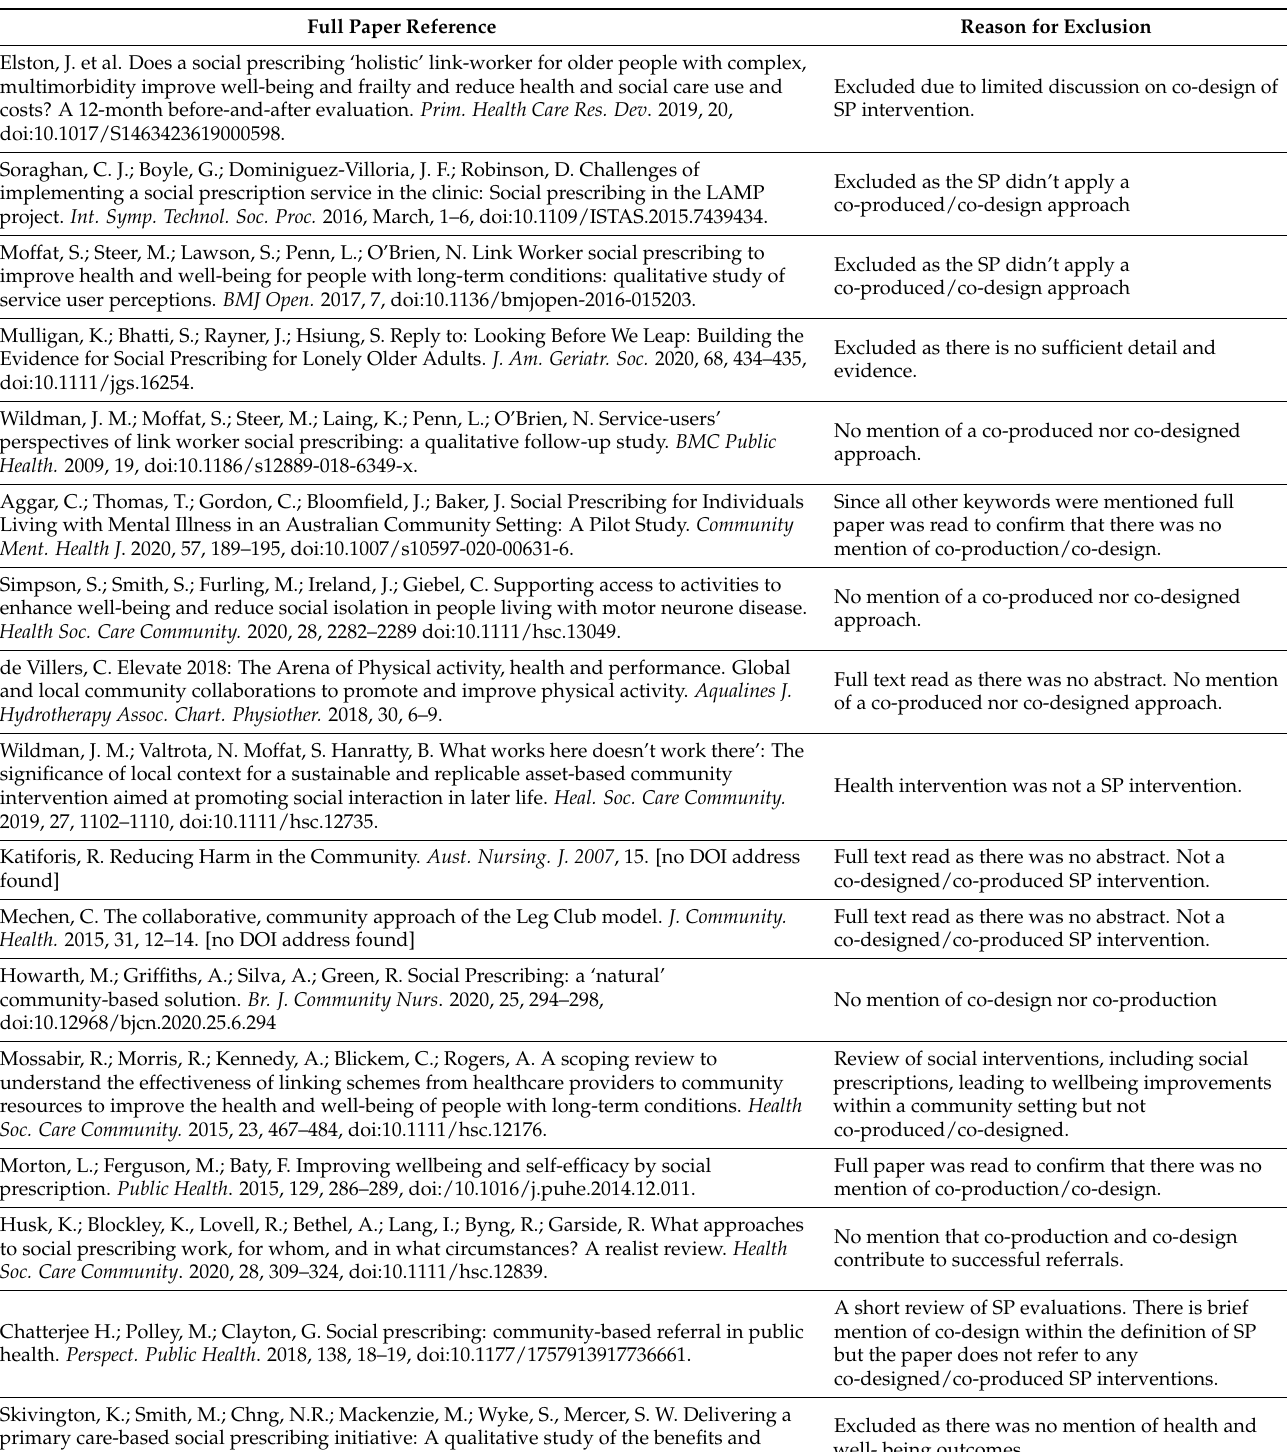
Table A4. List of full text-articles excluded and reasons for